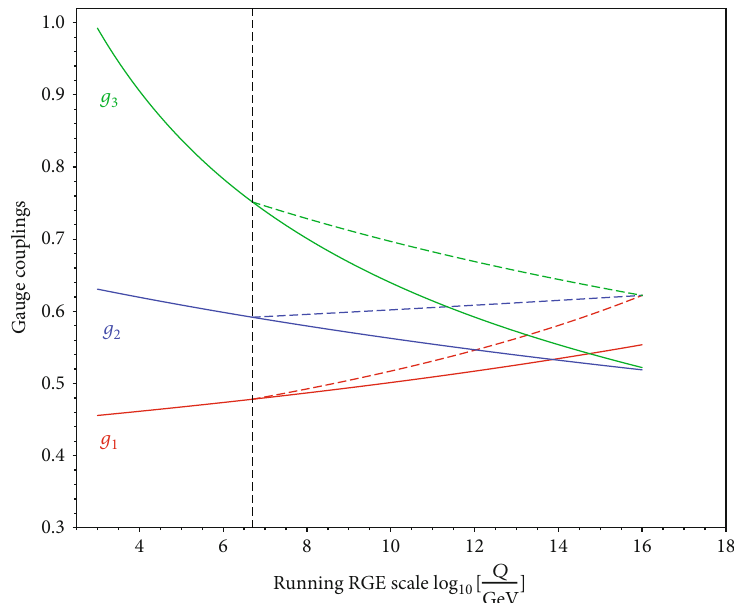
Figure 3: Solid lines represent the gauge coupling evolution for the standard model. Dotted lines represent the gauge coupling uni fi cation for our benchmark points (Table